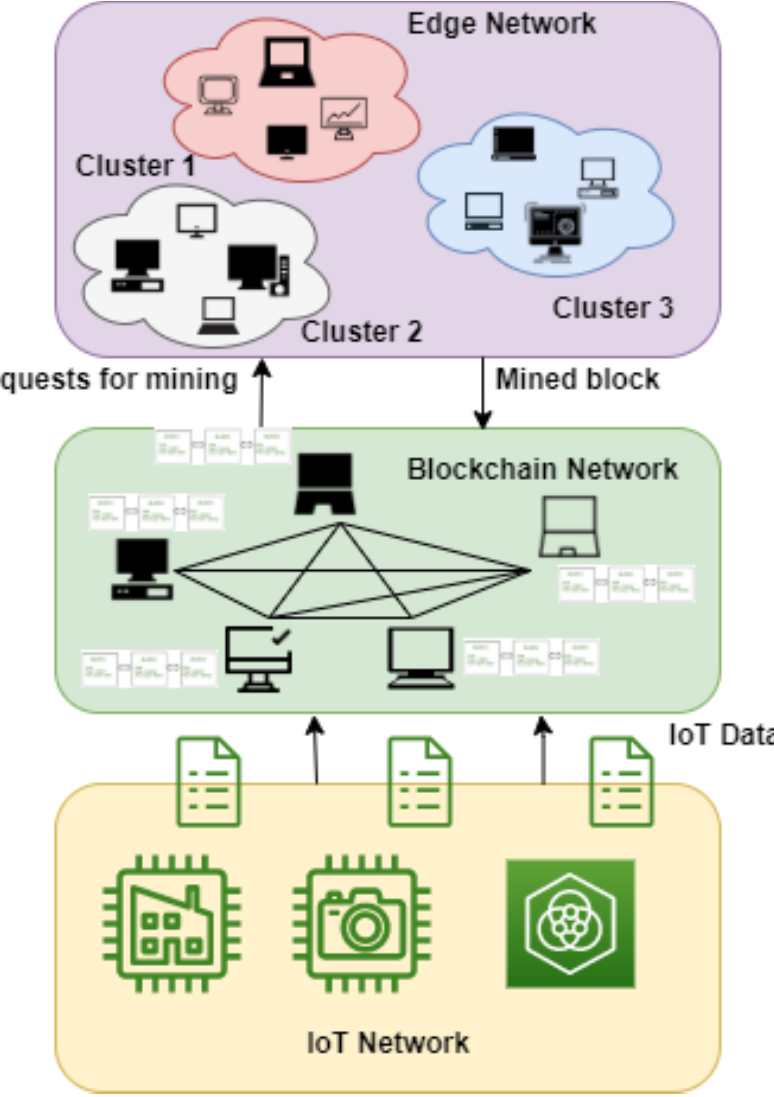
Figure 4. Proposed